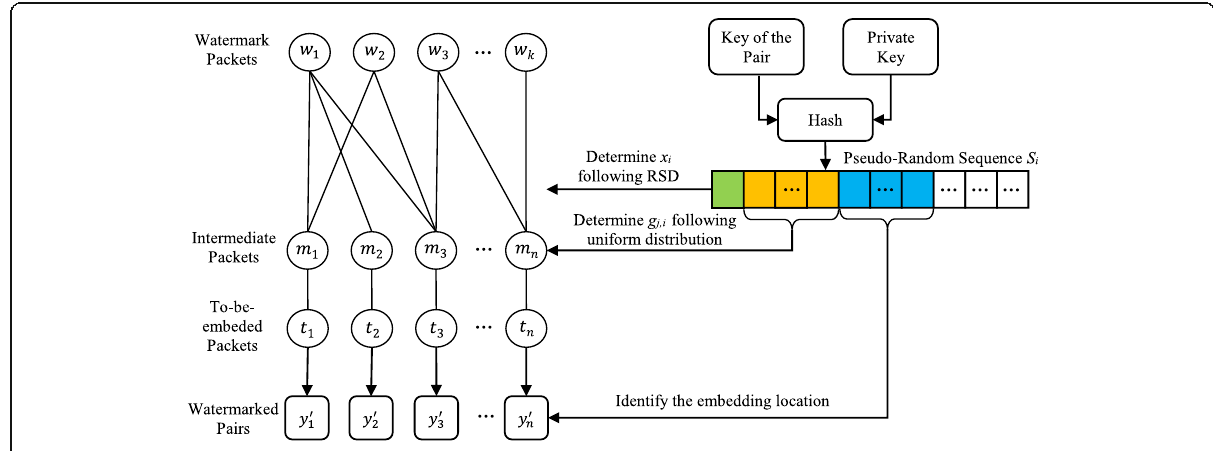
Fig. 4 Sketch of watermark embedding